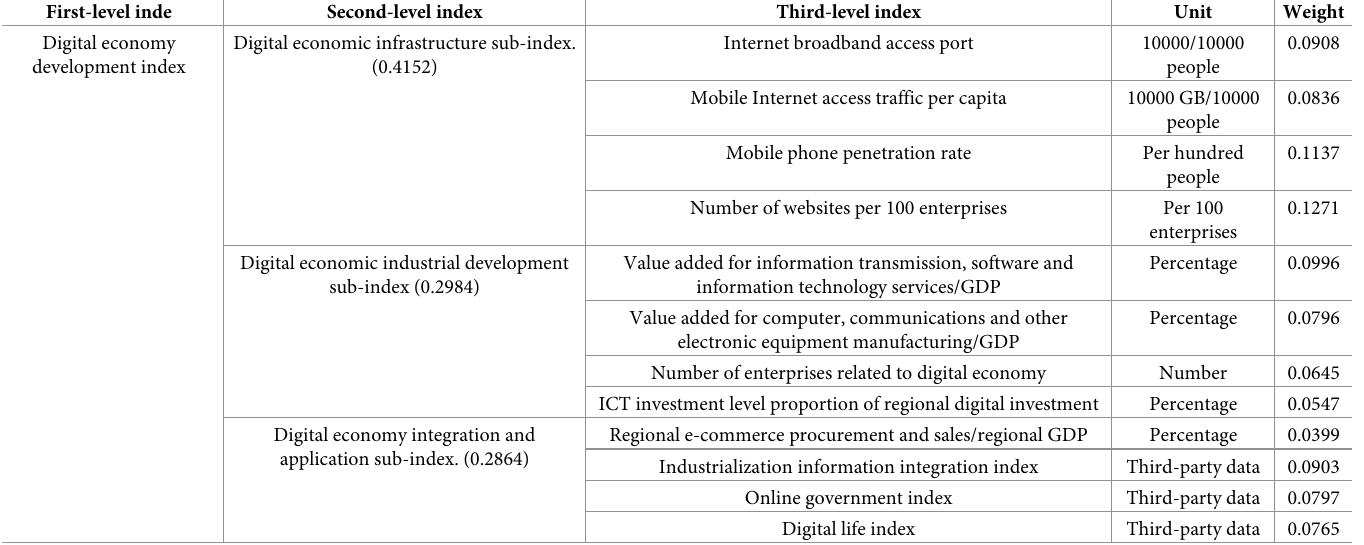
Table 1. Digital economy measurement index system and its